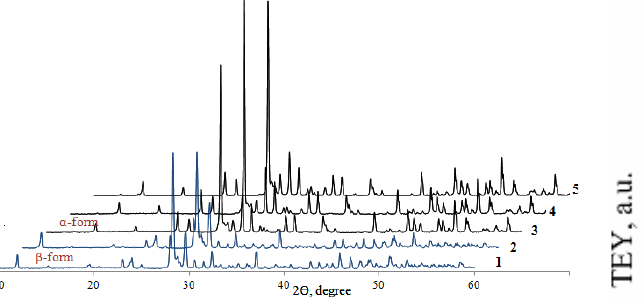
Figure 4: Diffraction patterns of BiNb 1− x Mn x O 4− δ sample in triclinic (x=0.01 (1), 0.02 (2)) and orthorhombic (x=0.03 (3), 0.04 (4), 0.06 (5); synthesis temperature – 750 ∘ C, 120 h) modifications.